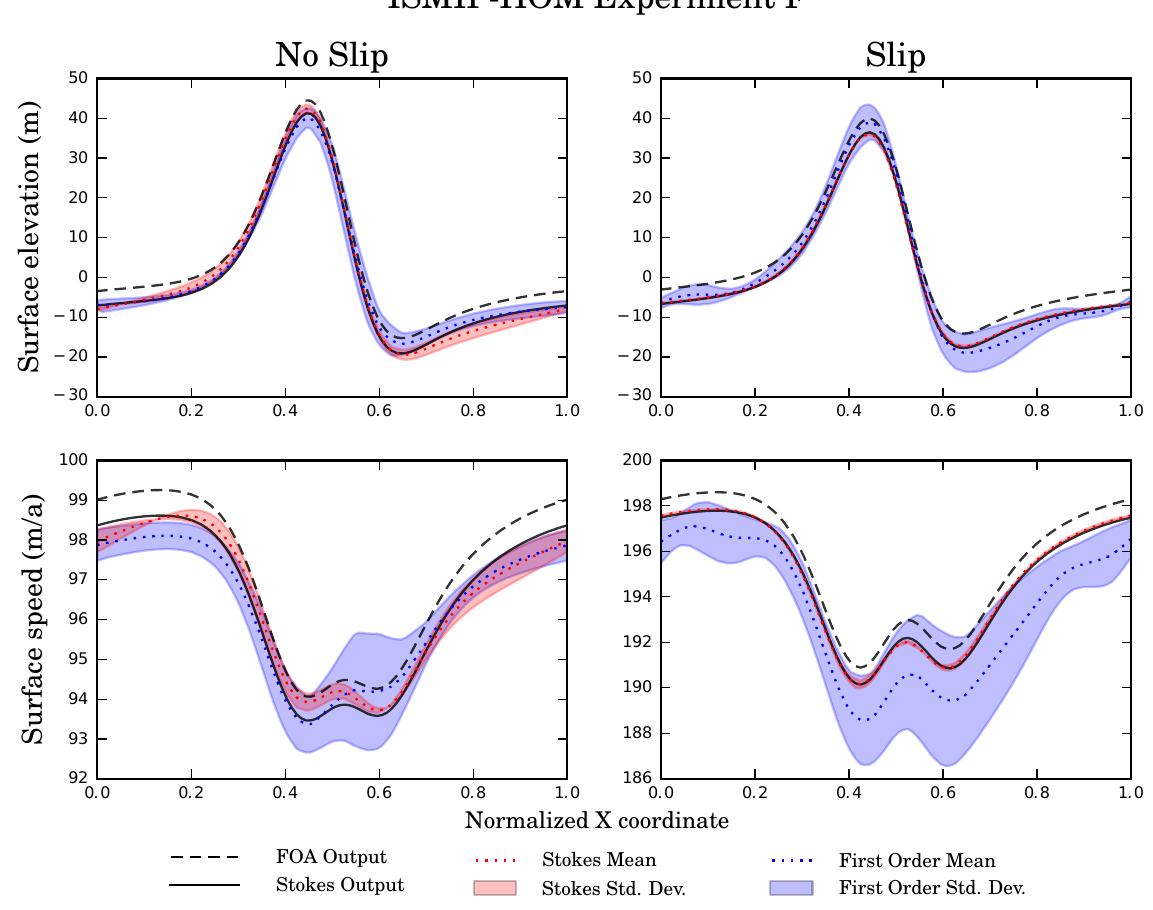
Fig. 9. ISMIP-HOM F performed using first-order and Stokes’